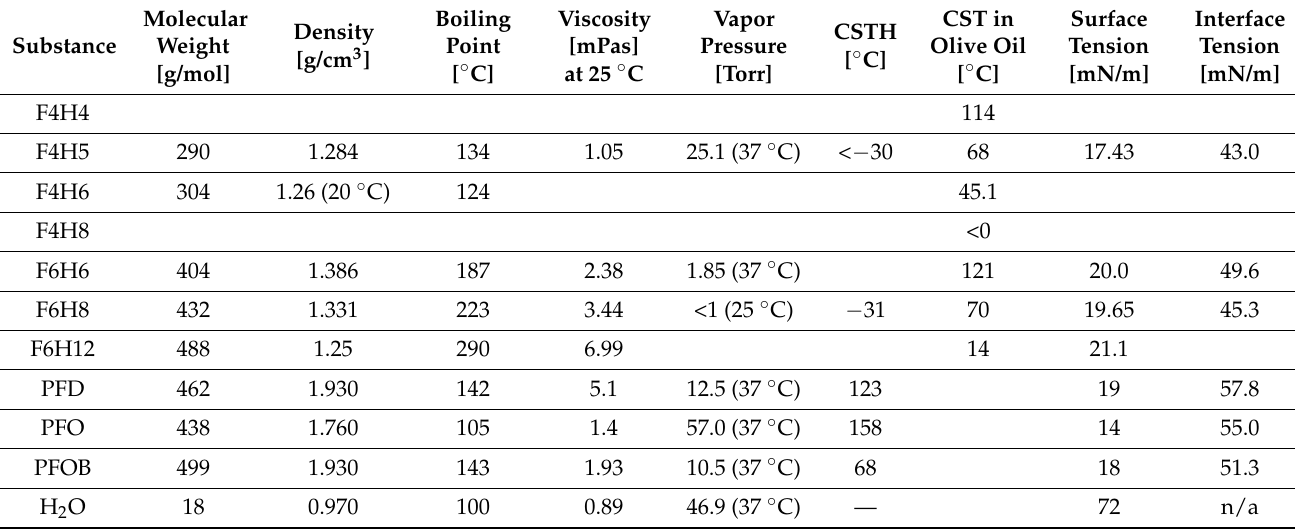
Table 1. Physicochemical properties of the semifluorinated alkanes perfluorobutylbutane (F4H4), perfluorobutylpentane (F4H5), perfluorobutylhexane (F4H6), perfluorobutyloctane (F4H8), perflu- orohexylhexane (F6H6), perfluorohexyloctane (F6H8), perfluorohexyldodecane (F6H12) and the perfluorocarbons perfluorodecaline (PFD), perfluorooctane (PFO), perfluooctylbromide (PFOB)